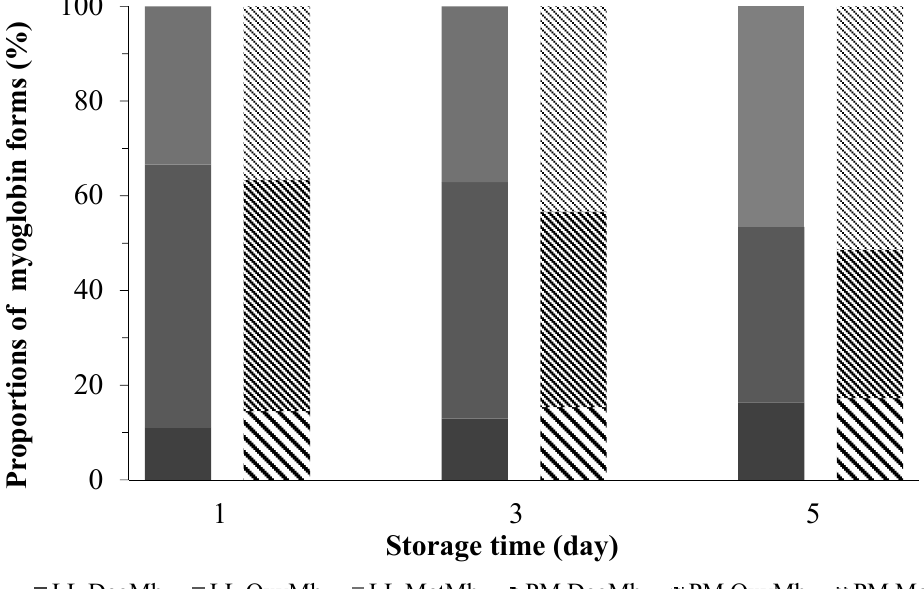
Figure 1. Changes in the relative proportions of MetMb, OxyMb, and DeoMb in ovine M. longissimus lumborum (LL) and M. psoas major (PM) muscles during postmortem storage (4 ± 1 °C). Table 1. Instrumental color attributes of ovine M. longissimus lumborum (LL) and M. psoas major (PM) muscles at 1, 3, and 5 days of postmortem storage (4 ◦ C).